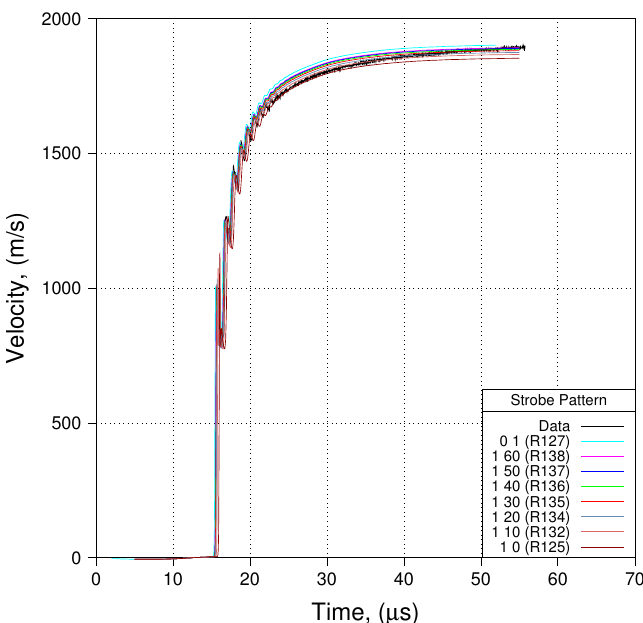
Figure 10. Impact of arbitrary Lagrangian–Eulerian (ALE) (Shot 01, Probe 07, Res 200 µ